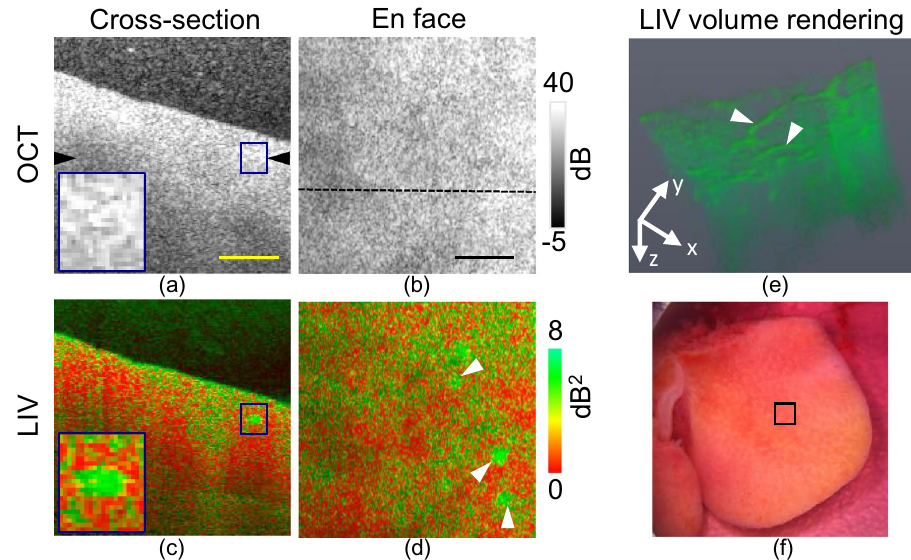
Figure 6. Dynamics imaging of early fibrotic mouse liver at the initial (0 h) time point. Cross-sections of ( a ) scattering OCT and ( c ) LIV images. ( b , d ) En face slices of the OCT and LIV images at the depth location indicated by black arrowhead in ( a ). ( e ) LIV volume rendering image and ( f ) original photograph of the measurement sample and the measurement area [square box]. Scale bar: 250